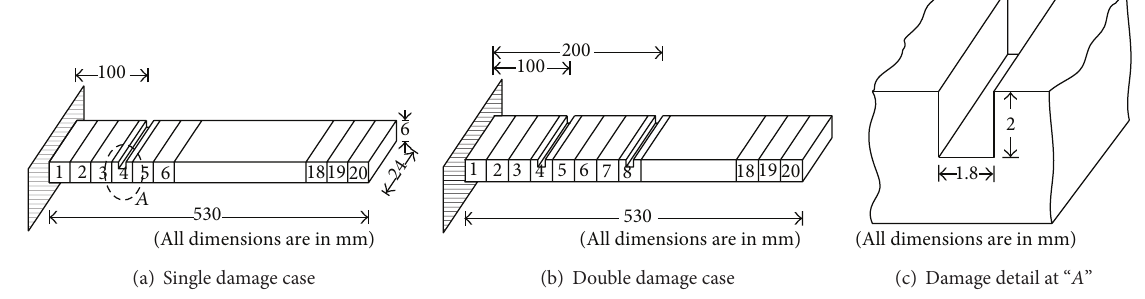
Figure 2: Experimental beam model (not to scale).